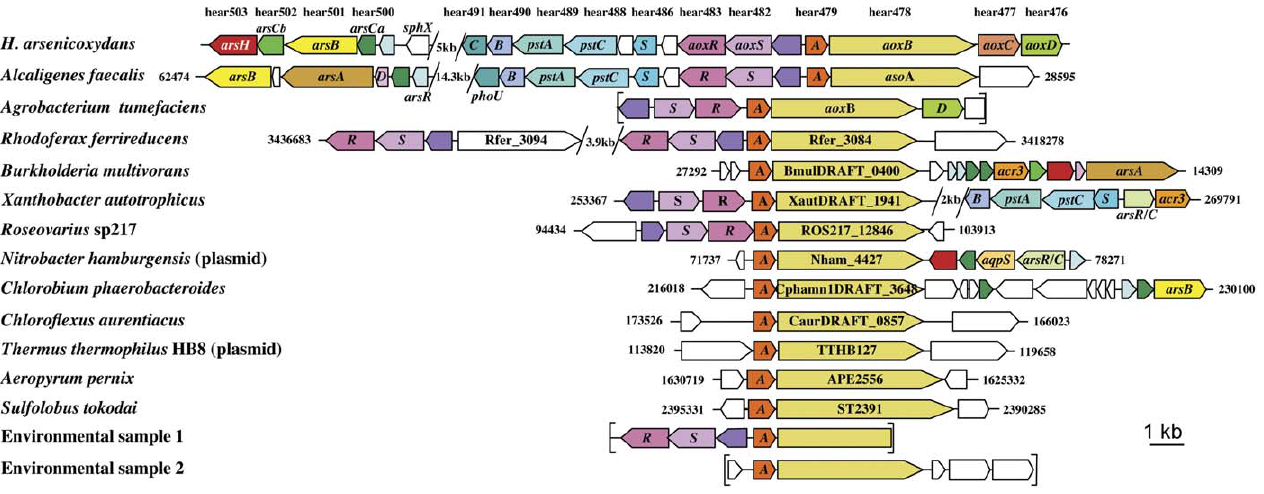
Figure 3. Organization of the aox Gene Cluster in H. arsenicoxydans and Various Arsenic-Metabolizing Microorganisms The aoxAB operon is close to arsenic-resistance genes in H. arsenicoxydans , A. faecalis, X. autotrophicus, N. hamburgensis, and C. phaeobacteroides. In the first three bacteria, these genes are associated with an aoxRS two-component regulatory system. In H. arsenicoxydans, the CDS number of aoxABCD, aoxRS, and arsRCBCH are hear 0479–0476, hear 0483–0482, and hear 0499–0503, respectively. Sequence information of other genes was obtained from GenBank database and their localization on the chromosome or the plasmid is given by nucleotide numbering. The following bacterial genomes were used: Alcaligenes faecalis , Agrobacterium tumefaciens , Rhodoferax ferrireducens , Burkholderia multivorans , Xanthobacter autotrophicus , Roseovarius sp217, Nitrobacter hamburgensis , Chlorobium phaerobacteroides , Chloroflexus aurentiacus , Thermus thermophilus HB8, Aeropyrum pernix , Sulfolobus tokodai ,